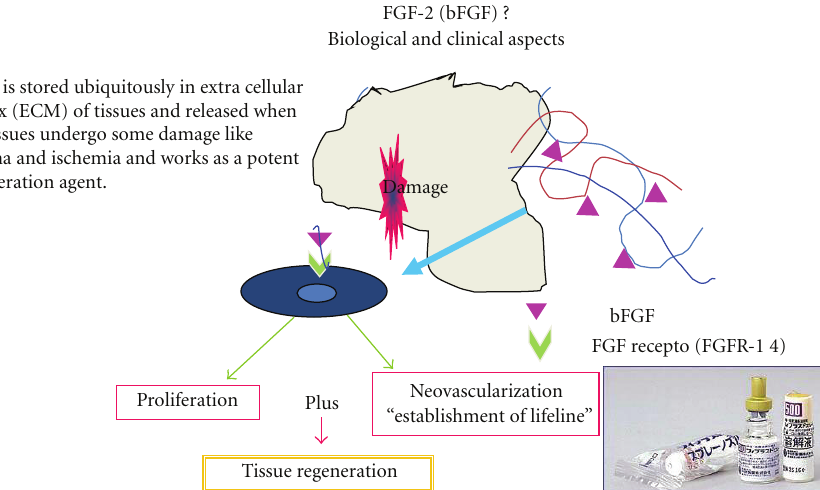
Figure 3: Freeze-dried bilayer artificial dermis made of bovine dermis. The outer membrane of silicone layer is easily removed and easily soaked with cell-containing solution.